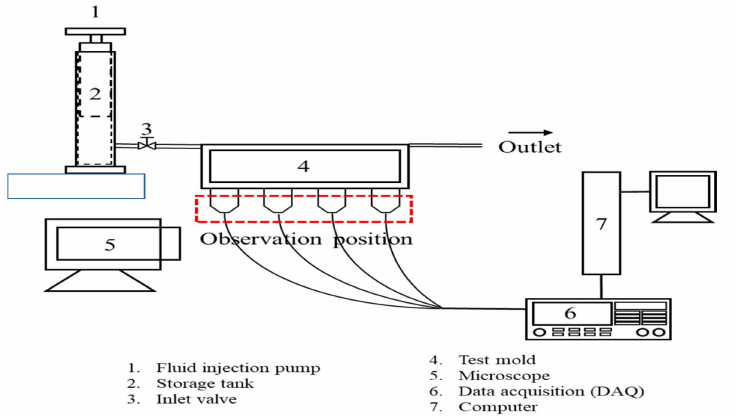
Figure 1. A schematic of the experimental apparatus for the observation of tow behavior in double- scale porous media.